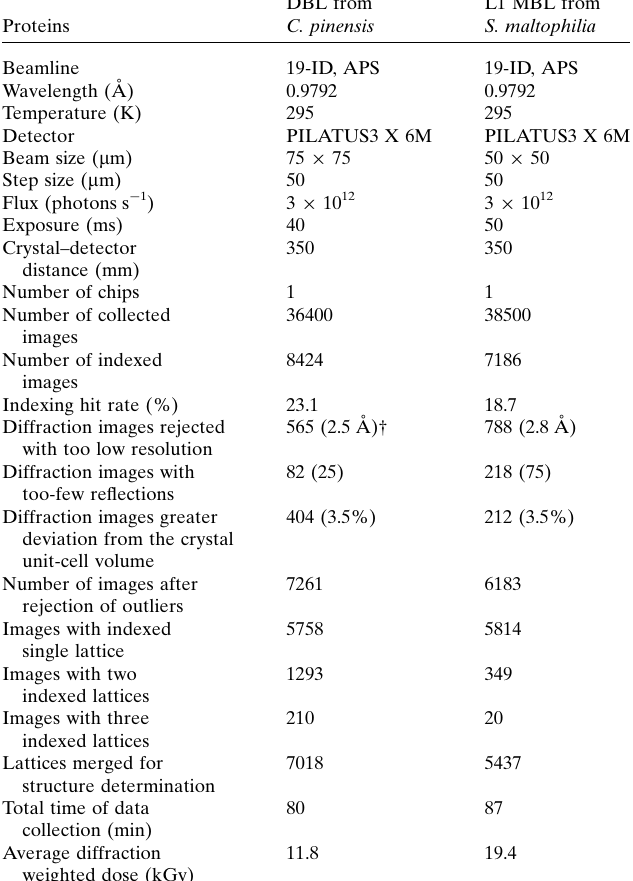
Table 1 Experimental setup and SSX data collection